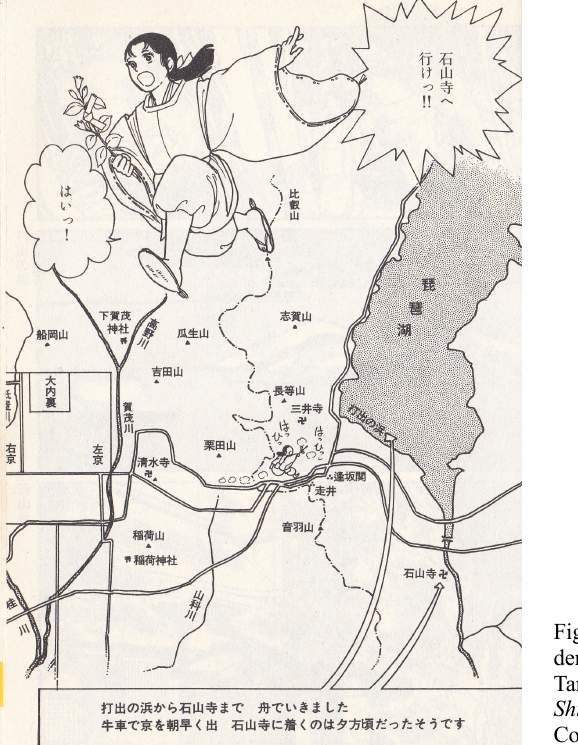
Figure 5. Map to Ishiyama- dera temple (Kosakabe